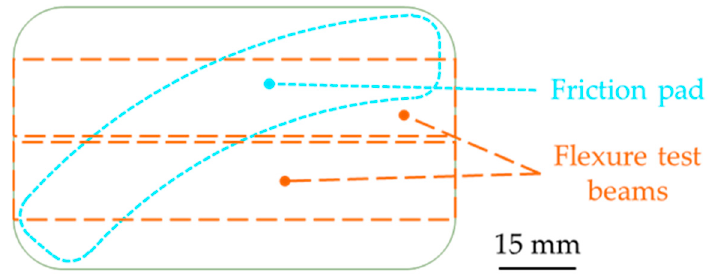
Figure 6. Sampling geometry for one friction sample or two toughness test samples out of an original molded lump.